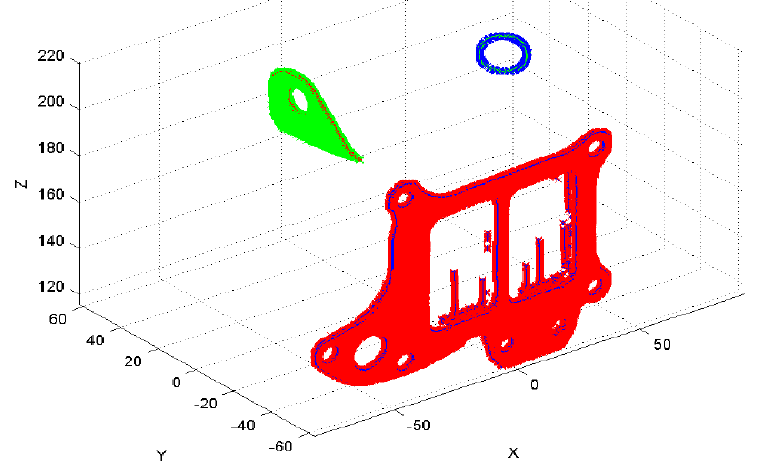
Figure 15. Several iterations